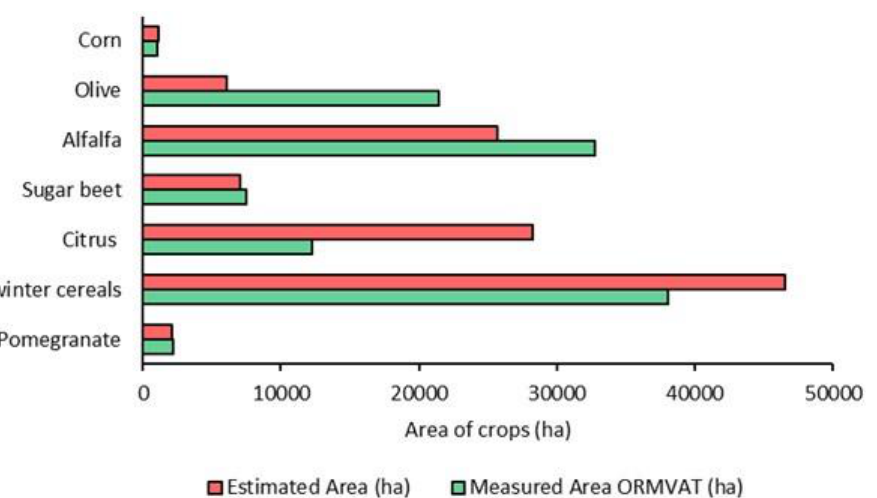
Figure 12. Estimated area using the RF classification and measured area based on the Tadla Agricultural Development Regional Office (ORMVAT) for the TIP crops.